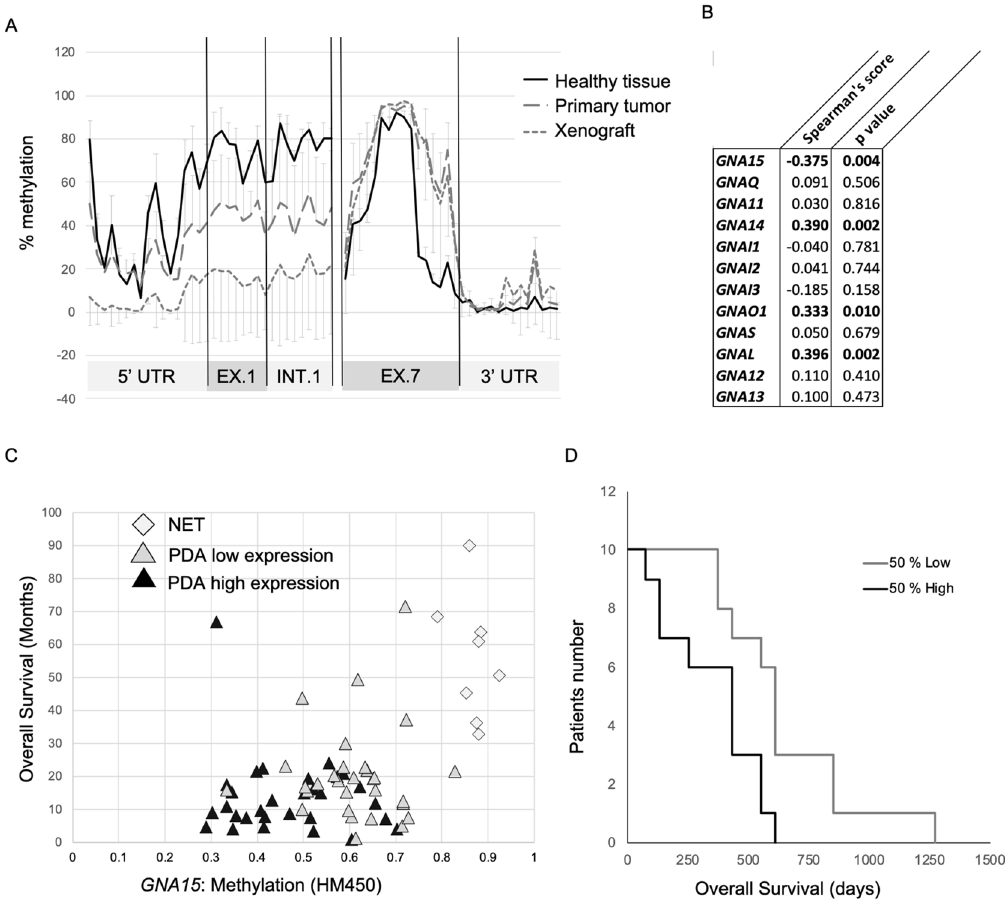
Figure 3. Demethylation, ectopic GNA15 expression and survival. ( A ) GNA15 gene methylation was mapped at single CpG in apparently normal tissue, and xenografted tumors, matched with primary tumors when available (gray bars represent standard deviation. n = 4 for normal tissues and primary tumors and n = 22 for xenografts). ( B ) Spearman’s correlation between Gα subunits expression levels and survival according to the TCGA-PAAD cohort (n = 59 samples). The isotypes associated to a significant p value (< 0.05) are in bold. No apparent correlation with tumor stages was found for any Gα gene. ( C ) The methylation level reported in the TCGA-PAAD court plotted against survival data distinguishing the NET and the PDAC patients further subdivided based on low (bottom 30%) vs high (top 30%) GNA15 expression levels. ( D ) GNA15 high expression is associated with poor survival. Kaplan survival curve in patients in the cytology group. All 20 patients were divided in two groups based on GNA15 expression (log RNA Seq V2 RSEM, log-rank test; z = 2.67, p =